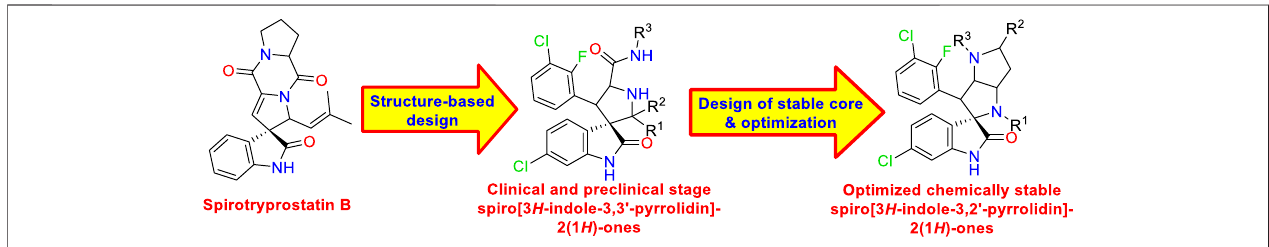
FIGURE 1 | Design of spiro [3 H -indole-3-3 ′ -pyrrolidin]-2(1 H )-one MDM2 inhibitors and optimization to the chemically stable spiro [3 H -indole-3-2 ′ -pyrrolidin] -2(1 H )-ones series.